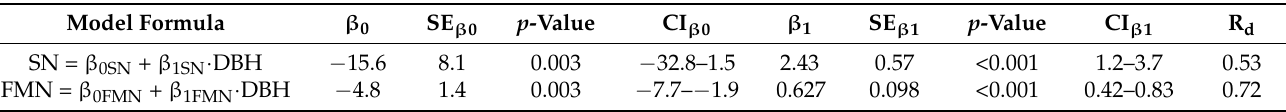
Table 2. Allometric equations for the mass of needles (FMN) and needle surface (SN) determination in Scots pine stands from DBH values.